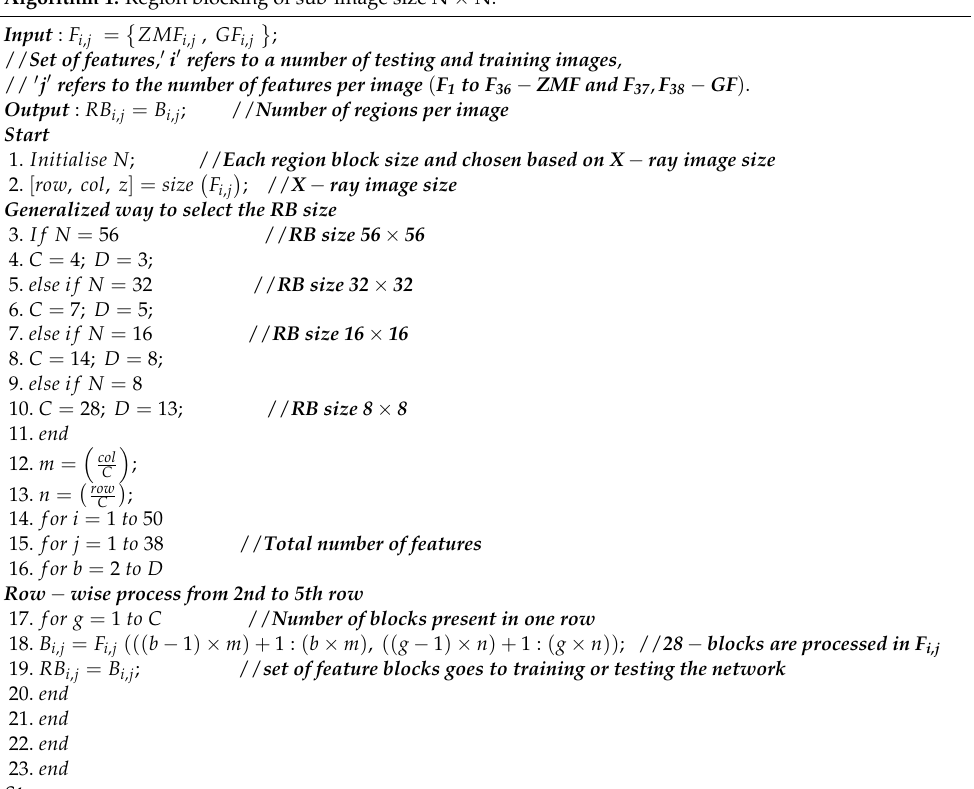
Algorithm 1. Region blocking of sub-image size N × N.